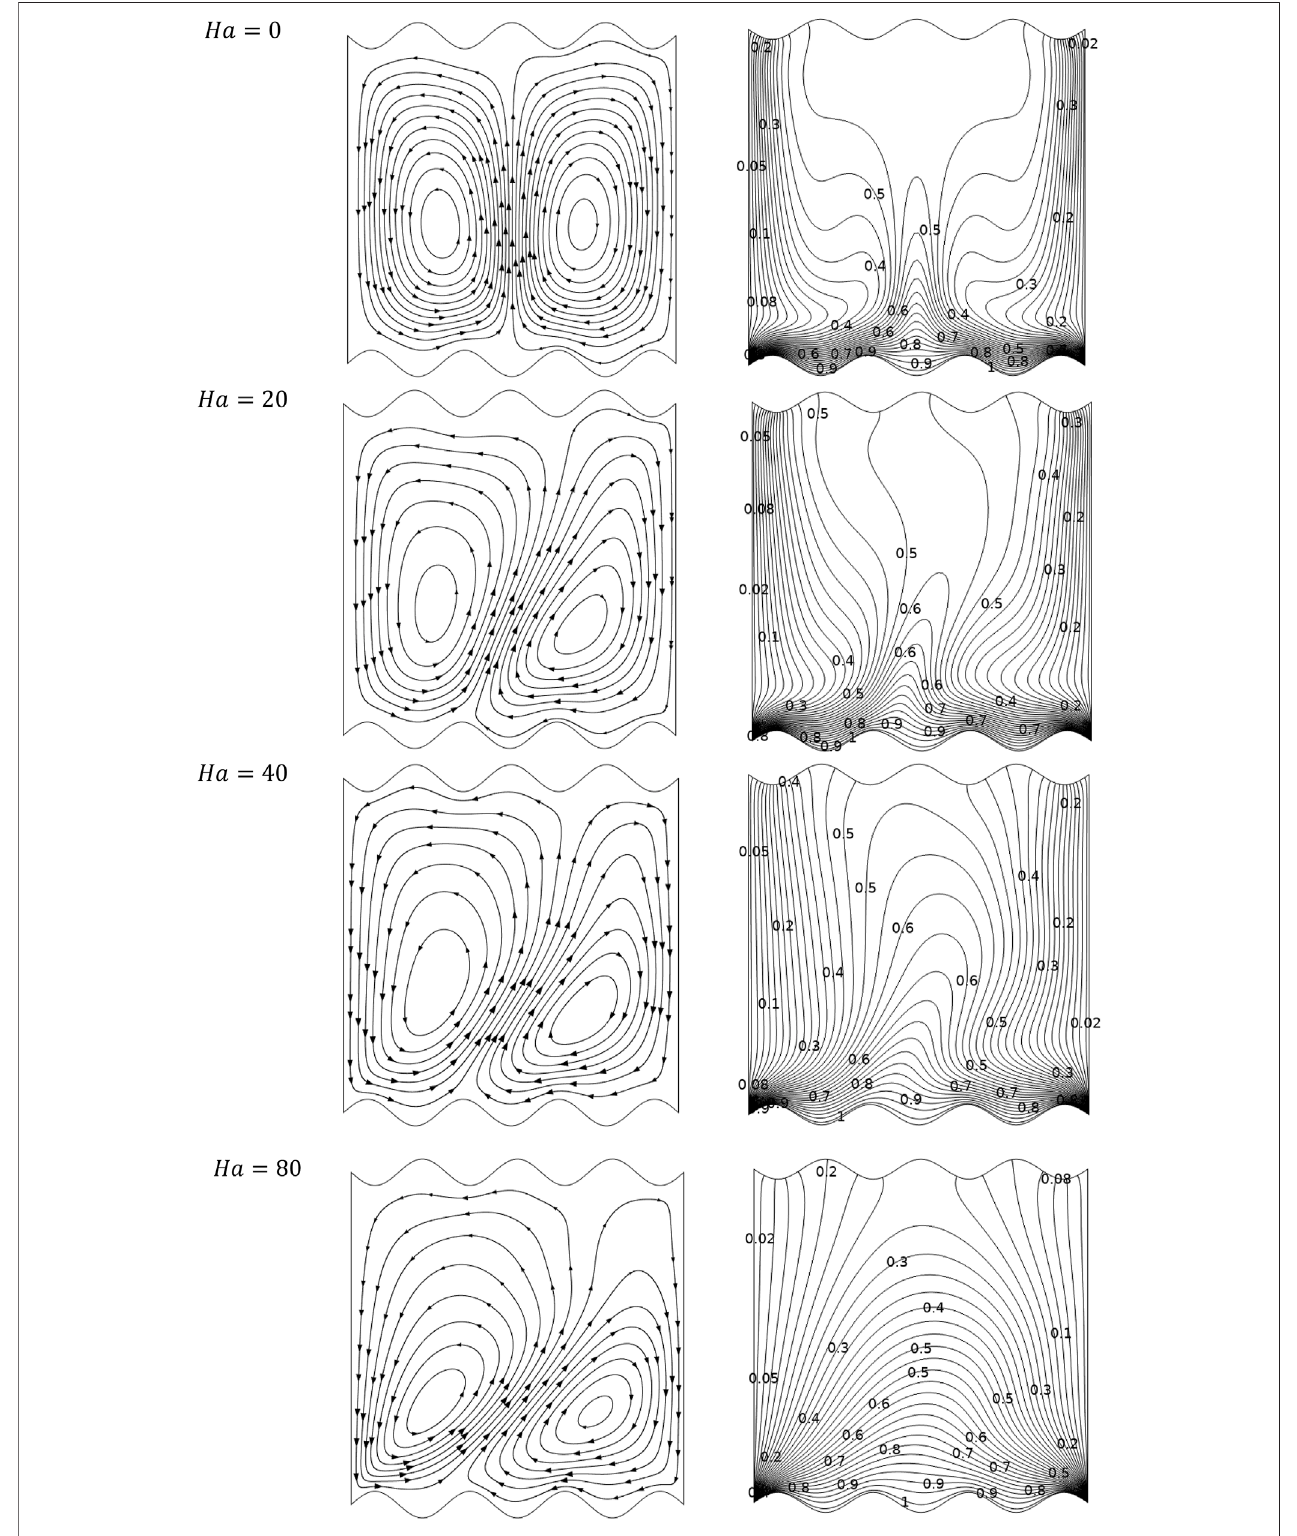
FIGURE 3 | Impacts of Ha on streamline (left) and isotherm contour (right) with Ra (cid:1) 1 E 5 and. ϕ (cid:1) 0 . 04 .